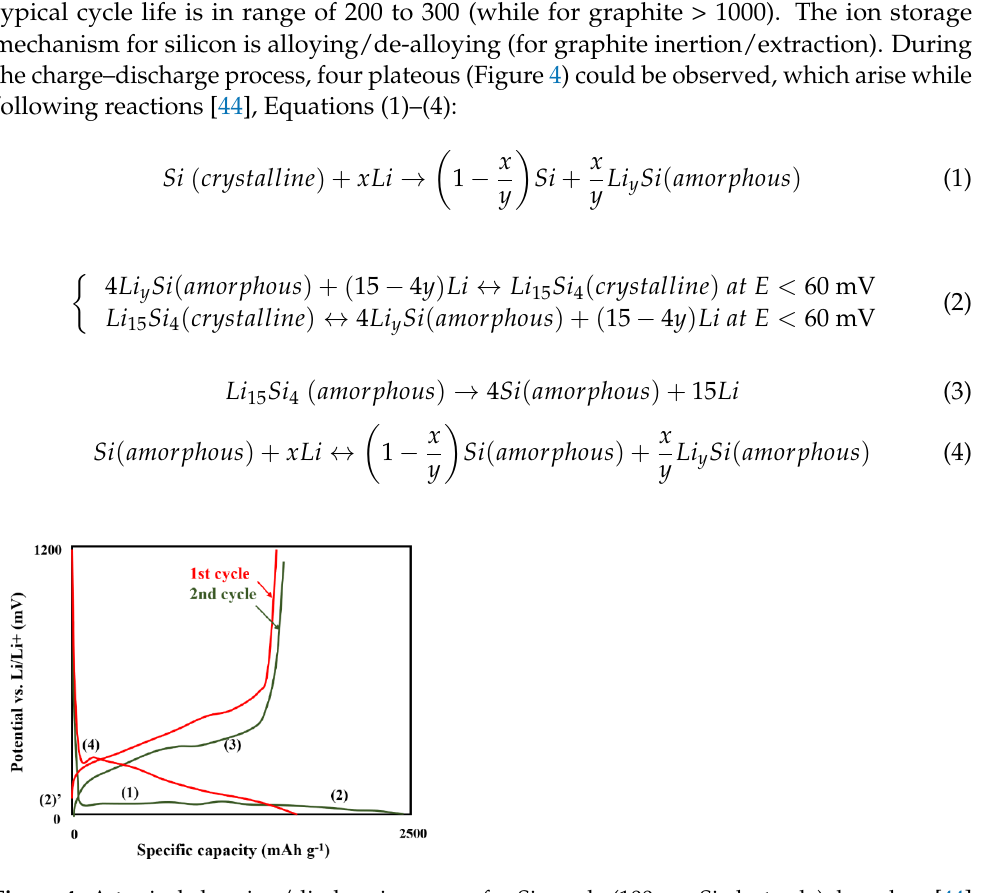
Figure 4. A typical charging/discharging curve for Si anode (100 nm Si electrode), based on [44] (Equations (1)–(4)).